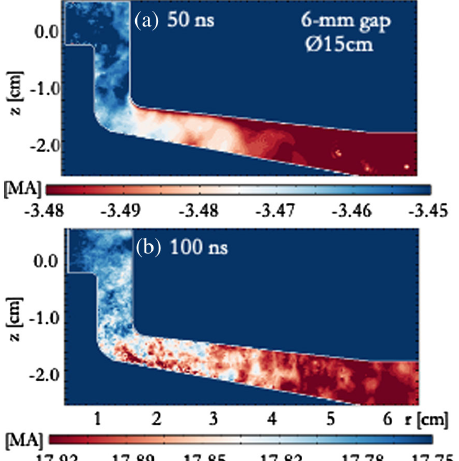
FIG. 11. Current distribution in the ∅ 15 cm 2-mm gap sim- ulation [Fig. 8(b)] at (a) 50 ns and (b) 100 ns.